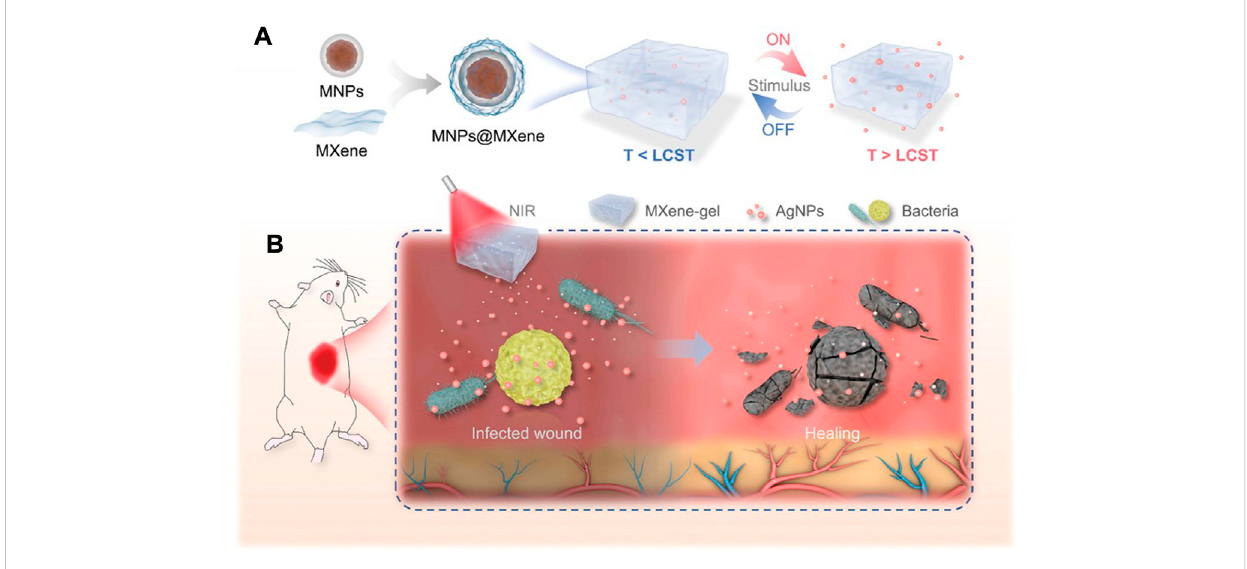
Schematic illustration of the preparation and application of NIR-responsive MXene-based hydrogel system. (A) The formation and drug release process of the MXene-based hydrogel system. (B) Deep chronic infected wound treated with NIR responsive AgNPs-loaded MXene-based hydrogel system. (Yang et al., 2022b).